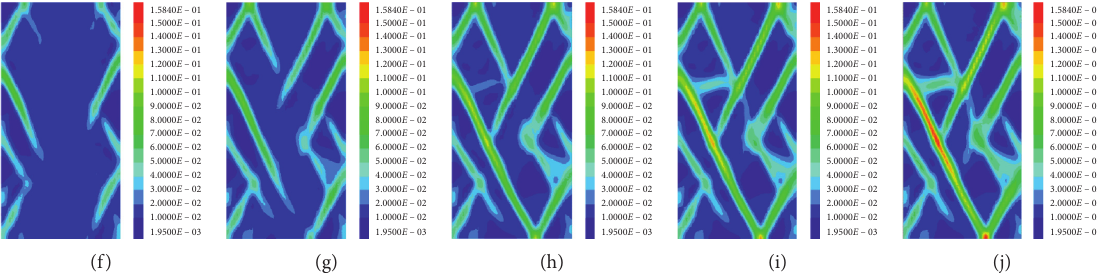
Figure 13: Shear strain evolvement at different stress level in simulated triaxial compression test under confining pressure of 20MPa.